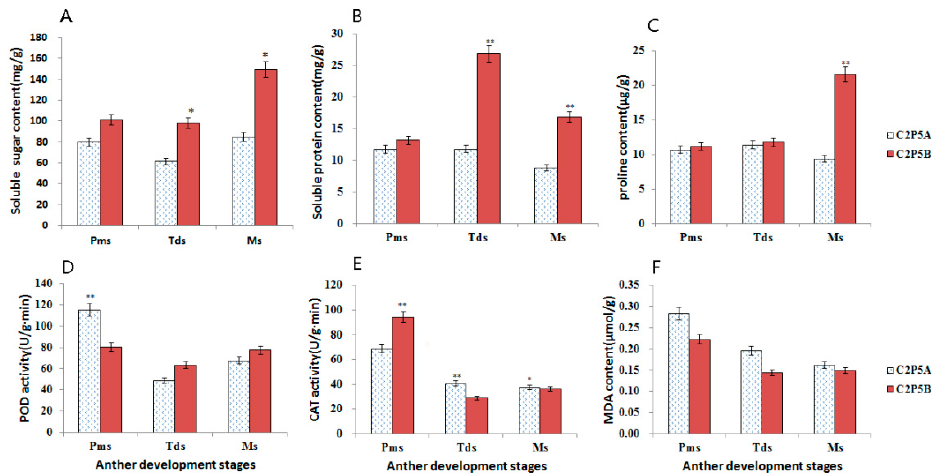
Figure 3. Determination of physiological indices of anthers at di ff erent developmental stages. ( A ) Determination of soluble sugar content. ( B ) Determination of soluble protein content. ( C ) Determination of proline content. ( D ) Determination of POD activity. ( E ) Determination of CAT activity. ( F ) Determination of MDA activity. PMs, pollen mother cell stage; Tds, tetrad stage; Ms, mononuclear stage; C2P5A, CMS line; C2P5B, maintainer line. The white columns indicate male sterile line C2P5A; red columns indicate the maintainer line C2P5B. The error bars represent SD (** p < 0.01, * p < 0.05), three biological replicates were performed.